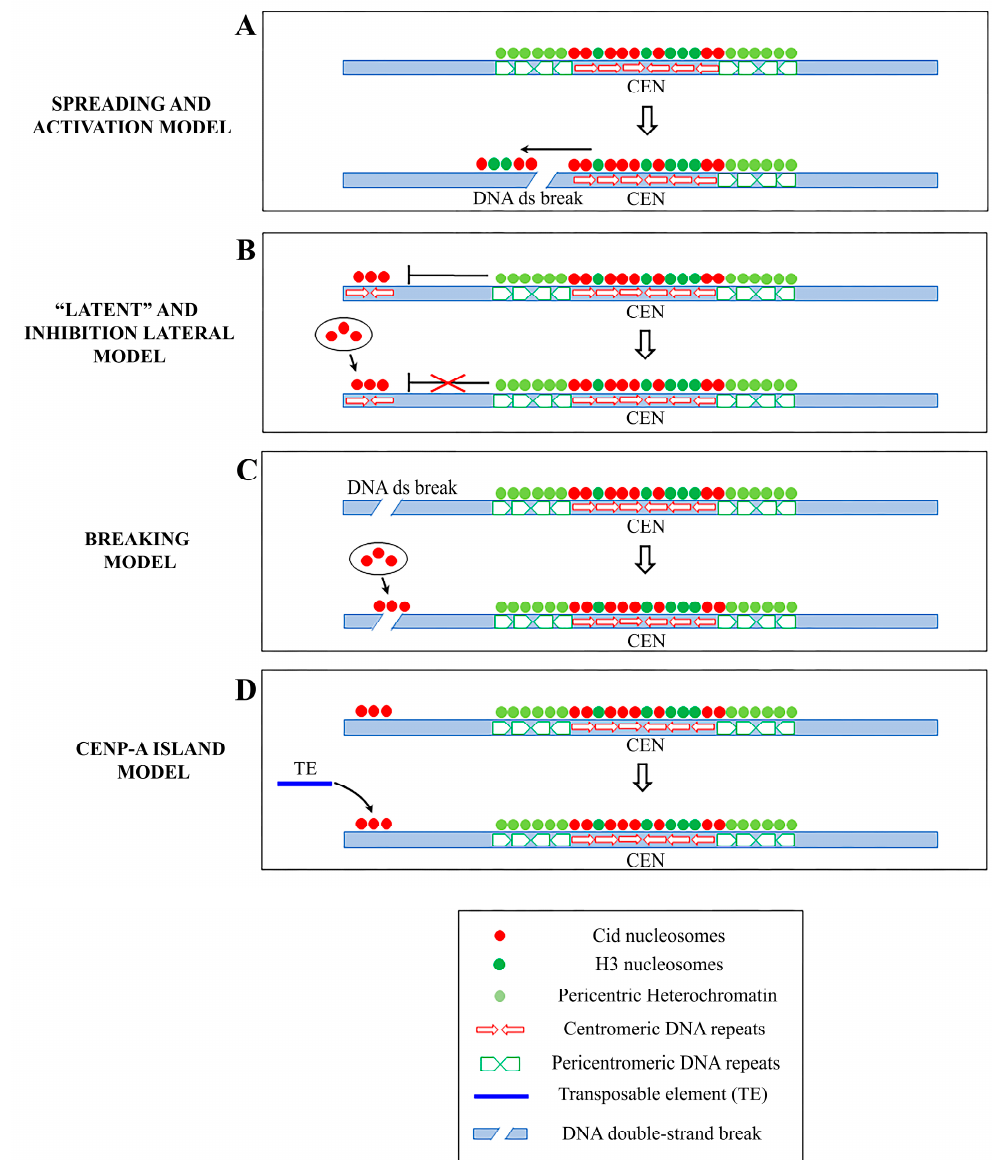
Figure 2. Schematic representation of the principal models of neocentromere formation: ( A ) Spreading model and activation model: centromeric markers spread from centromere into adjacent areas inducing neocentromere formation near endogenous centromeres following a DNA double-strand break (DSB) ( B ) Latent centromere model and inhibition lateral model: ectopic sites along a chromosome have an intrinsic ability to perform centromeric activity, but they are repressed by a dominant centromere. When the endogenous centromere is inactivated, one of these sites becomes active and functionally competent. ( C ) DNA breaking model: a neocentromere emerges at a breaking site where centromeric protein A (CENP-A) is rapidly recruited. ( D ) CENP-A island model: CENP-A is deposited on islands of nucleosomes scattered along the chromosomes. A random insertion of a transposable element (TE) in a CENP-A-ectopic site represents the first step towards the formation of a new, fully functional centromere. Studies in primates show that relocation of the centromere within a chromosome may occur via neocentromere formation. The X chromosomes of three primate species share an identical order of genetic markers, but di ff erent centromeric locations [140]. The absence of rearrangements